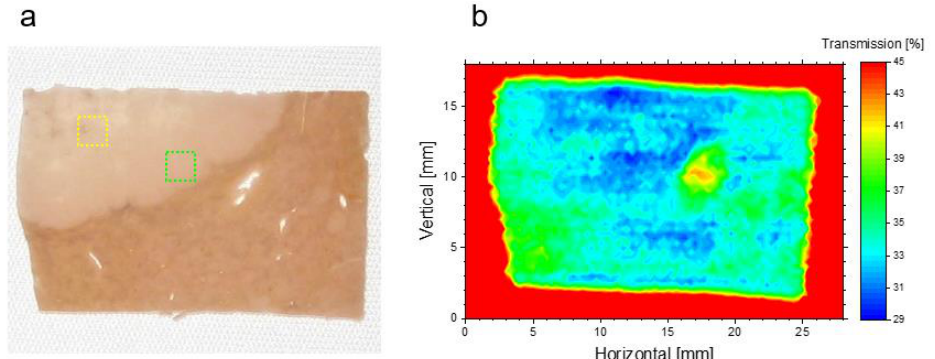
Figure 6. The visible image of formalin fixed liver ( a , b ) terahertz image of a liver tissue with underdeveloped fibrosis (sample #4). The yellow and green frames in ( a ) indicate the regions where the average transmission of the tumor tissue is evaluated.